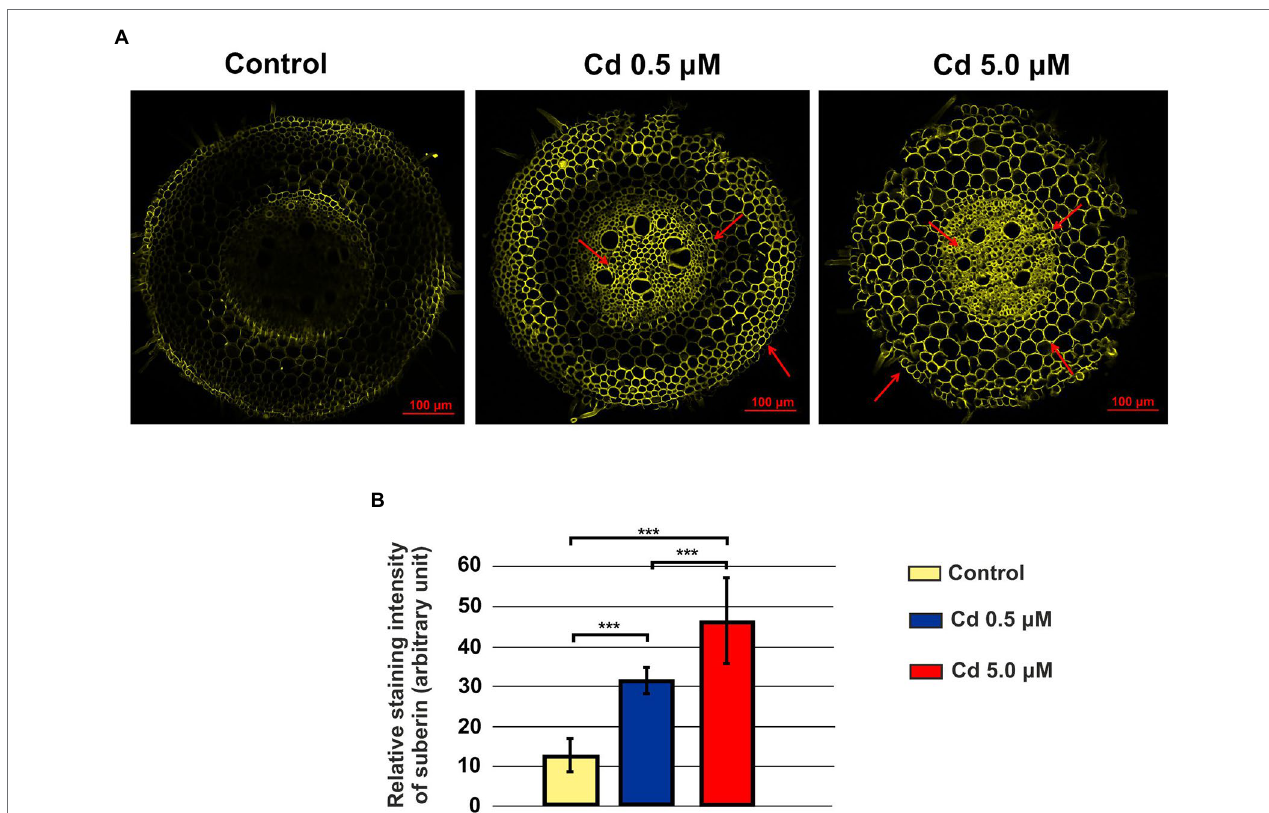
FIGURE 14 | Suberin in roots visualized by fluorescent imaging (staining with Fluorol Yellow 088). Panel (A) Yellow fluorescence in the images represents the binding of the dye to suberin; control: a faint but not bright signal was observed; Cd 0.5 μ M: fluorescence is localized in rhizodermis, endodermis and vascular cylinder (red arrows); Cd 5.0 μ M: fluorescence is also localized in the cell wall of the parenchyma cells of the cortical region (red arrows). Panel (B) Quantification of the relative intensity of the fluorescence signals. T -test value of p <